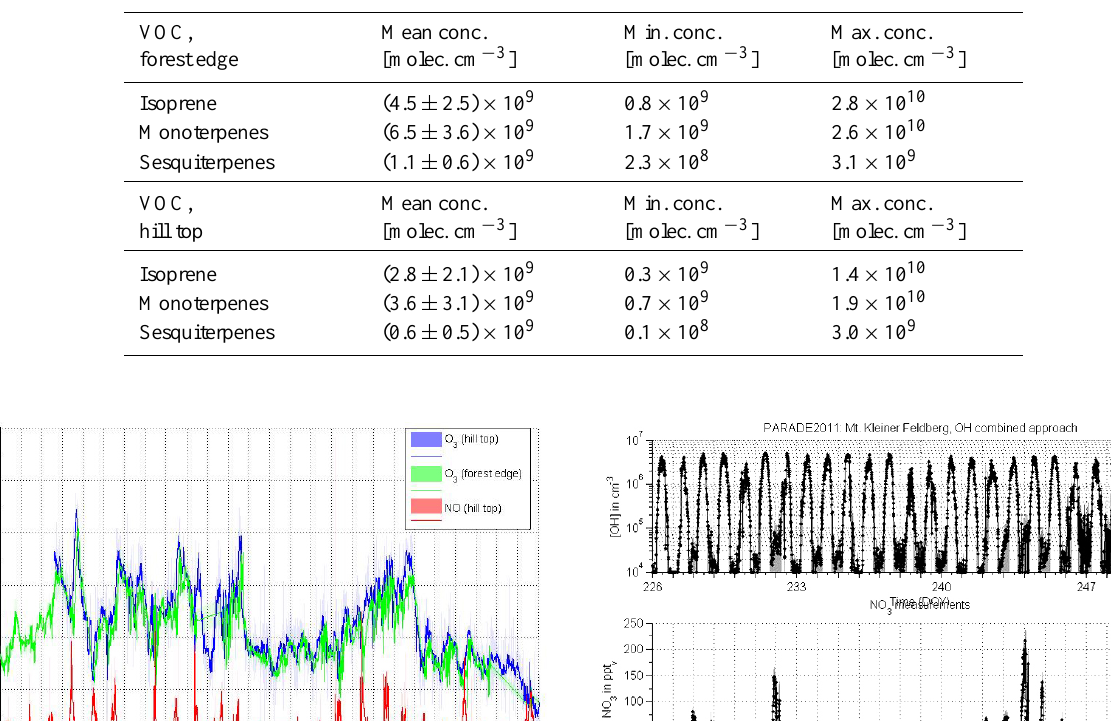
Table 3. Measured mean, minimum and maximum isoprene, mono- and sesquiterpene concentrations at the forest edge and at the 2011.